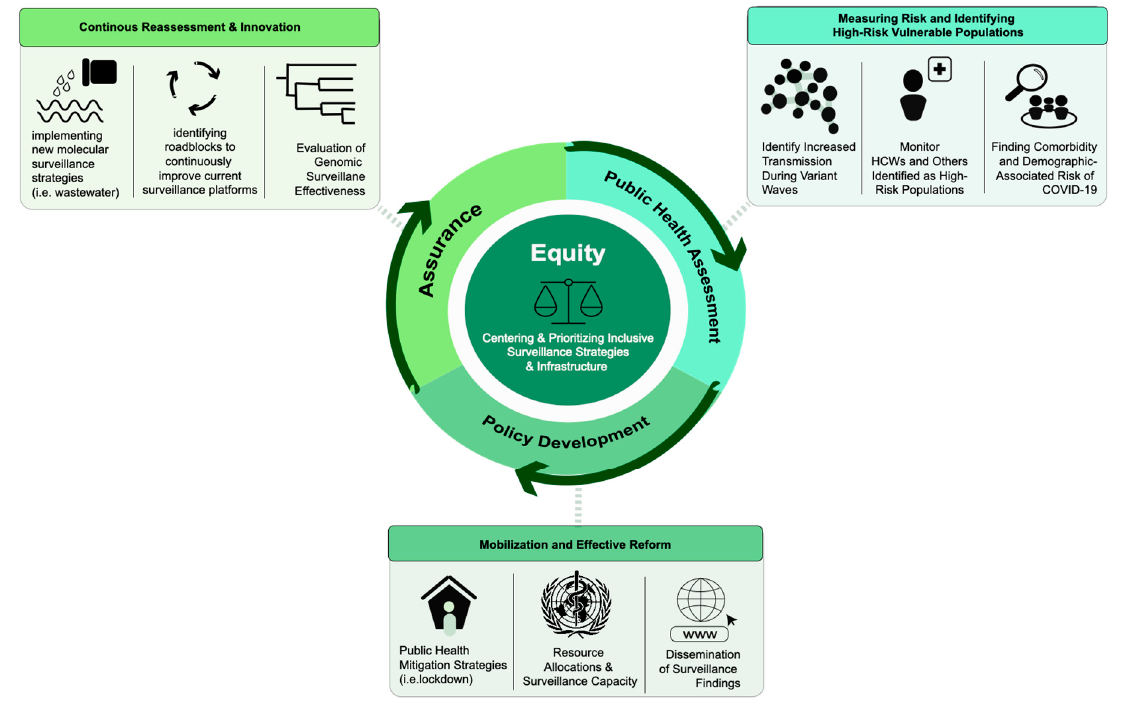
Figure 4. Public health framework and implications of genomic surveillance on public health responses. Framework based on the 10 essential public health services. This schematic represents each phase (assessment, policy development, assurance, and equity) in the context of SARS-CoV-2 genomic surveillance; HCW = healthcare worker.